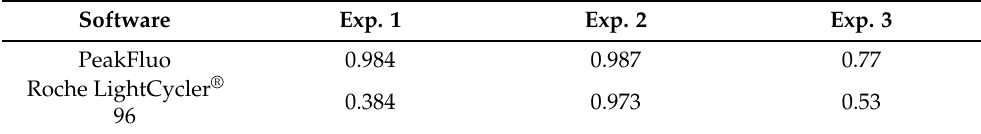
Figure 9. Boxplot showing the variation in normalised leptin concentrations for three experiments on separate days ( A ). Linear fit of normalised leptin concentrations for three experiments on separate days with 95% confidence intervals ( B ). All samples were ran in triplicates and data were normalised by dividing each C t value by the average C t value for all concentrations in a given experiment. Table 3. Comparison of the coefficient of determination R 2 achieved by PeakFluo and by the Roche LightCycle ® 96 software on three separate